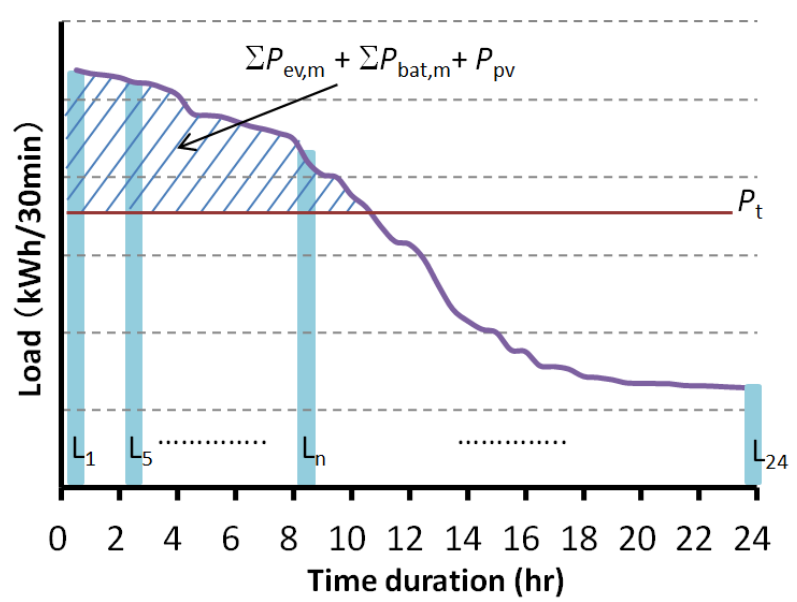
Figure 8. Load duration curve and the calculated peak-cut threshold.